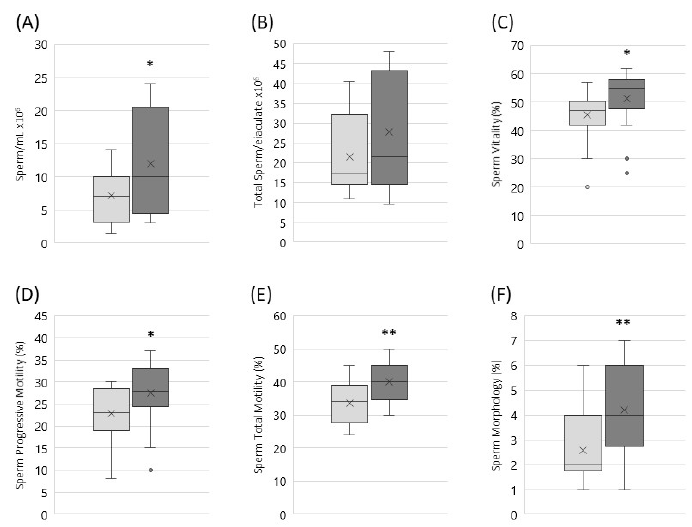
Figure 1. Sperm concentration ( A ); total sperm number ( B ); sperm vitality ( C ); progressive ( D ) and total ( E ) sperm motility; sperm morphology ( F ) before (T0; light grey) and after 3 months (T1; dark grey) treatment with nutraceutical preparation. Graphical diagrams are plotted as box–whisker plots, where boxes show the interquartile range with median and mean values, and whiskers represent min and max confidence intervals, outliers are represented as single dots (* p < 0.05; ** p < 0.01).